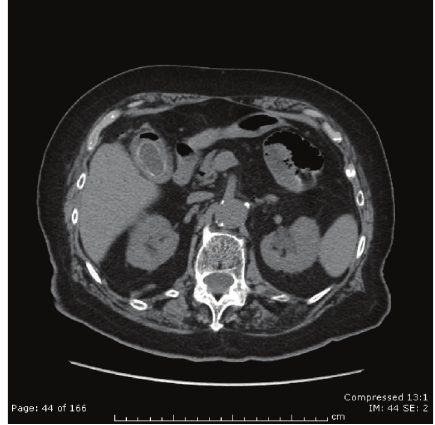
Figure 2: Computed tomography. Pneumobilia.